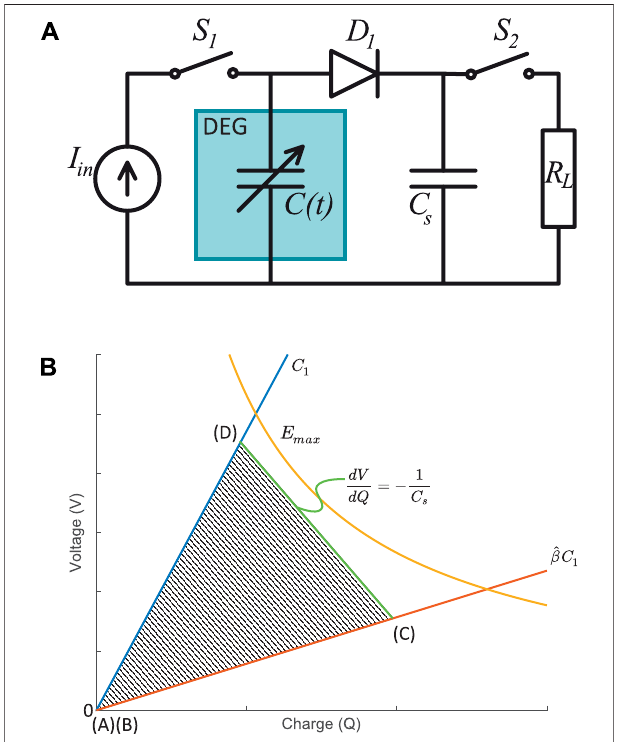
FIGURE2 | Triangular harvesting cycle. (A) The electronic circuitaround the DEG consists of a power supply, 2 switches, a diode, and a storage capacitor C s . The Resistance R L represents a load or a harvesting circuit to which the charges are transferred at the end of each cycle through the switch S 2 . (B) Triangular cycle in the Q-V plane. The slope of the segment (C)- (D) is controlled by the value of the storage capacitor.